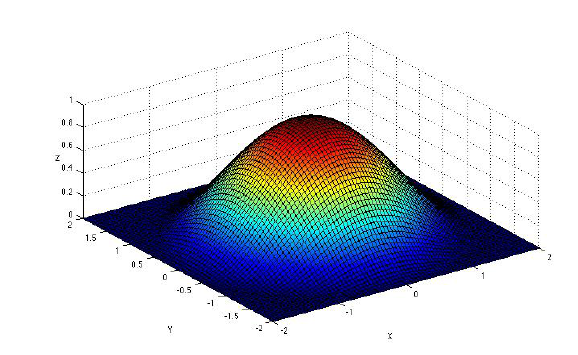
Fig. 1. Sensing capability